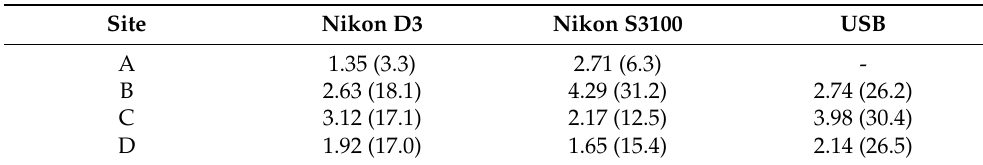
Table 4. Average residuals in GSD and in mm (in parenthesis) on check points (CP) for Nikon D3, Nikon S3100 and